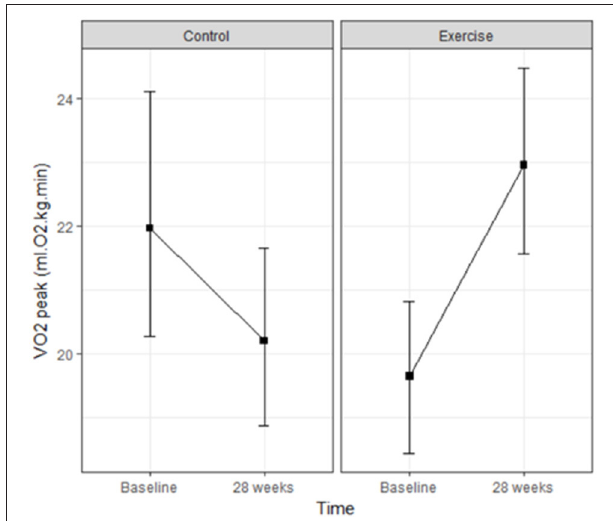
FIGURE 2 | Mean VO2 peak values at each of the evaluation times in the control and exercise groups [F (1, 58) = 31.43; p <